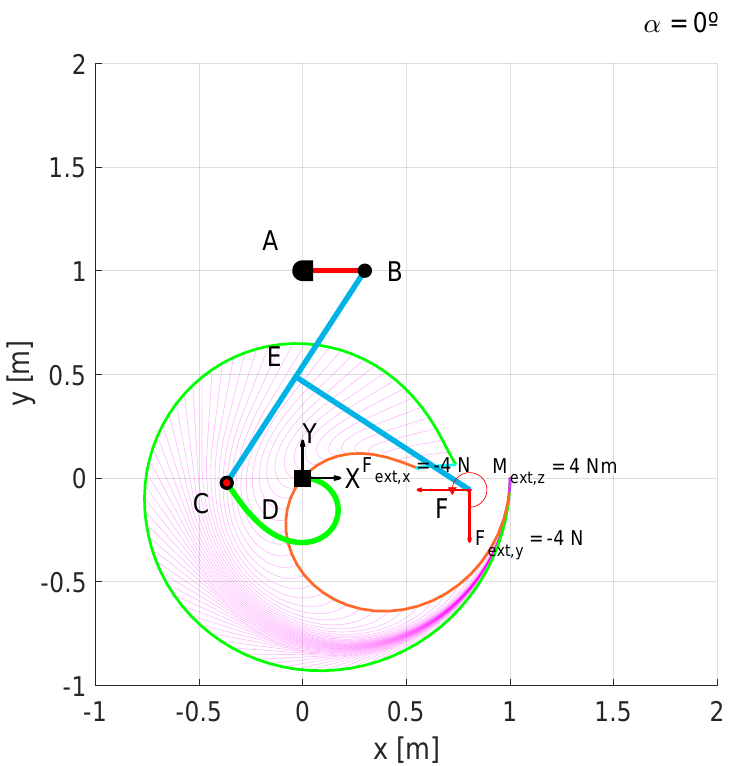
Figure 21. Third mechanism circuit under external loading of F ext , x = − 4 N, F ext , y = − 4 N, and M ext , z = 4 Nm. Initial position.